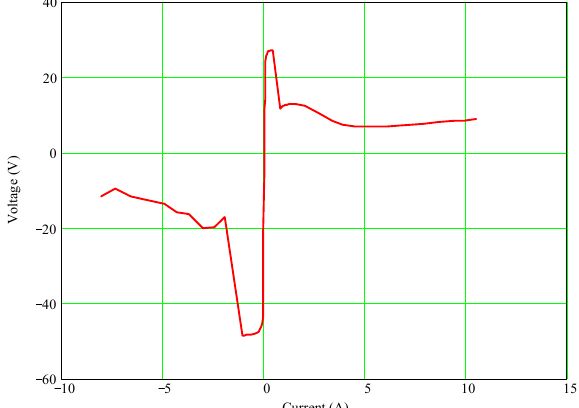
Figure 9: Typical V/I characteristic implemented in a Pspice model.